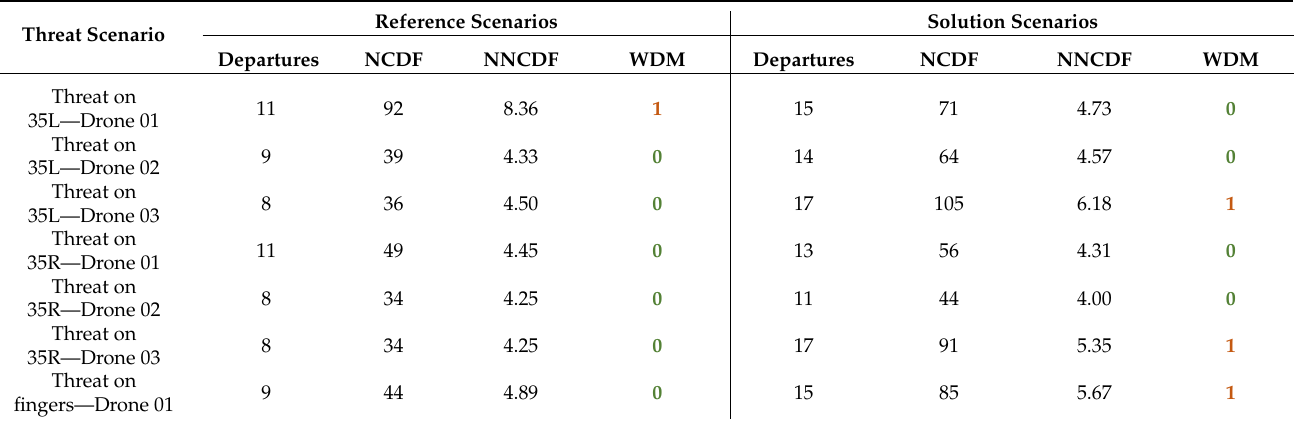
Table A4. Simulation results: workload metrics. The following colors are used for WDM values: red for high (2) value; orange for medium (1) value; green for low (0) value. Bold values respectively represent the mean and the standard deviation of WDM